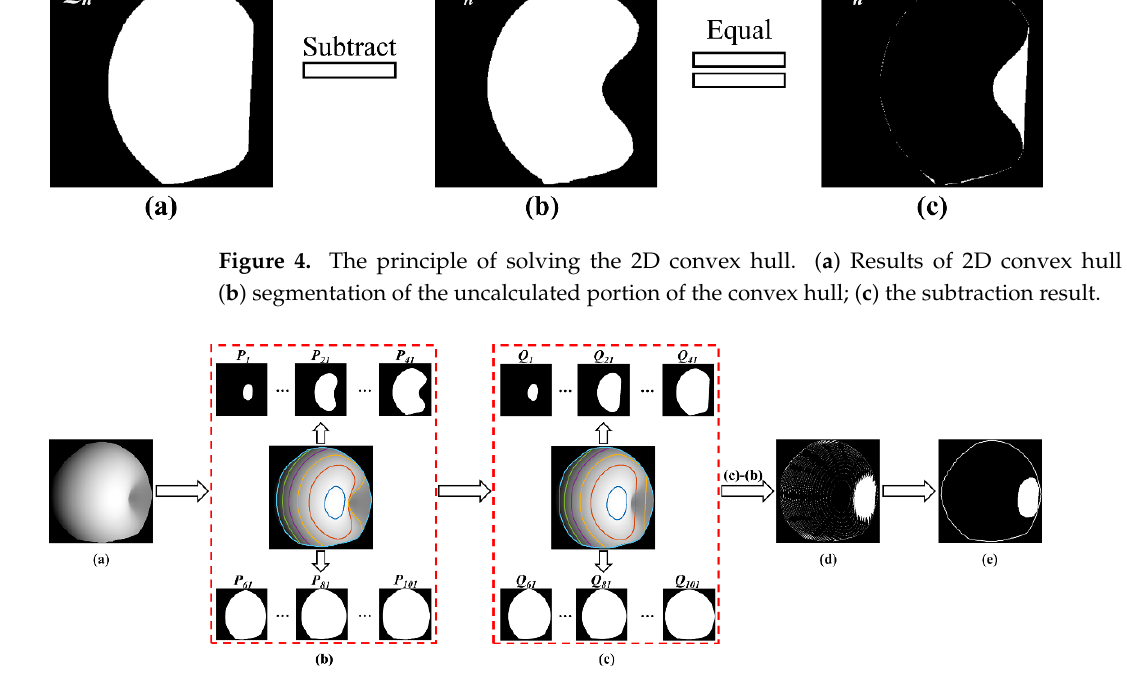
Figure 5. Schematic diagram of system to identify the stem and calyx. ( a ) Three-dimensional reconstruction result; ( b ) schematic of segmented lines and segmented results; ( c ) presentation of convex hull wire and 2D convex hull filled result; ( d ) superimposed results; ( e ) stem and calyx